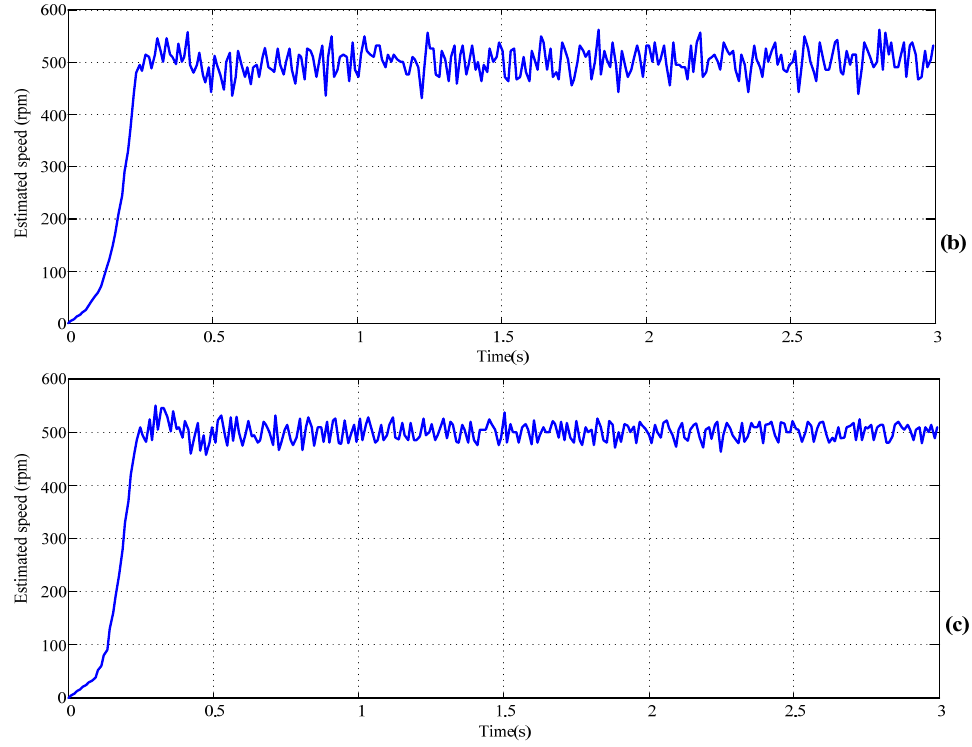
Figure 14. The step speed responses of 500 rpm with loading of 2 Nm by (a) encoder, (b) ISMO, and (c) NN-ISMO, respectively.